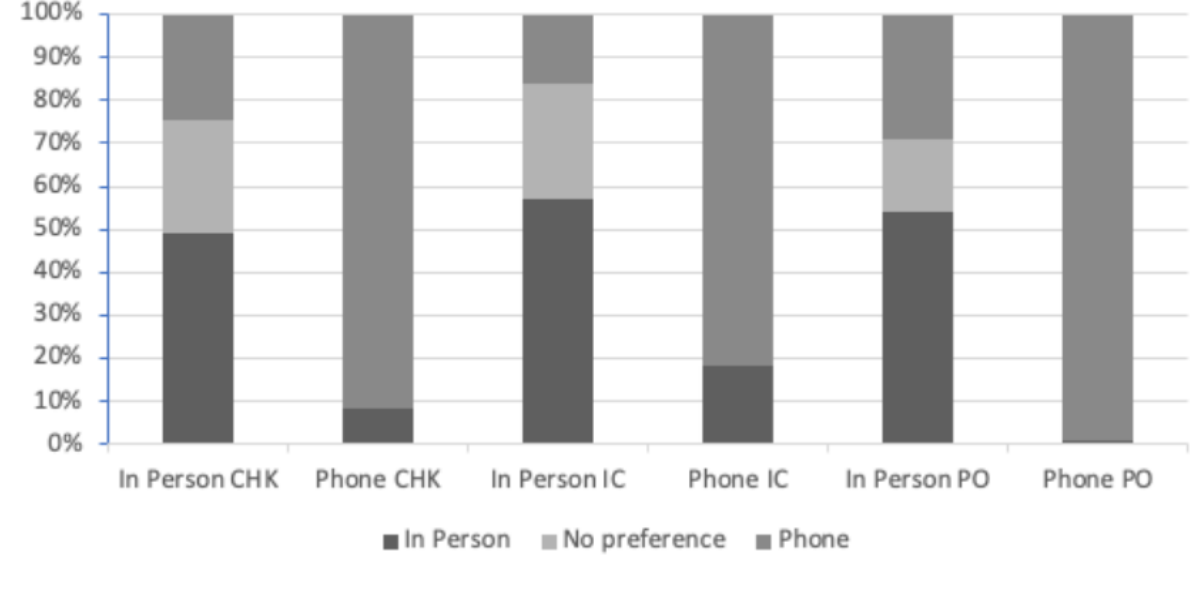
Figure 2. Preference for consultation by sex. M: male; F: female.